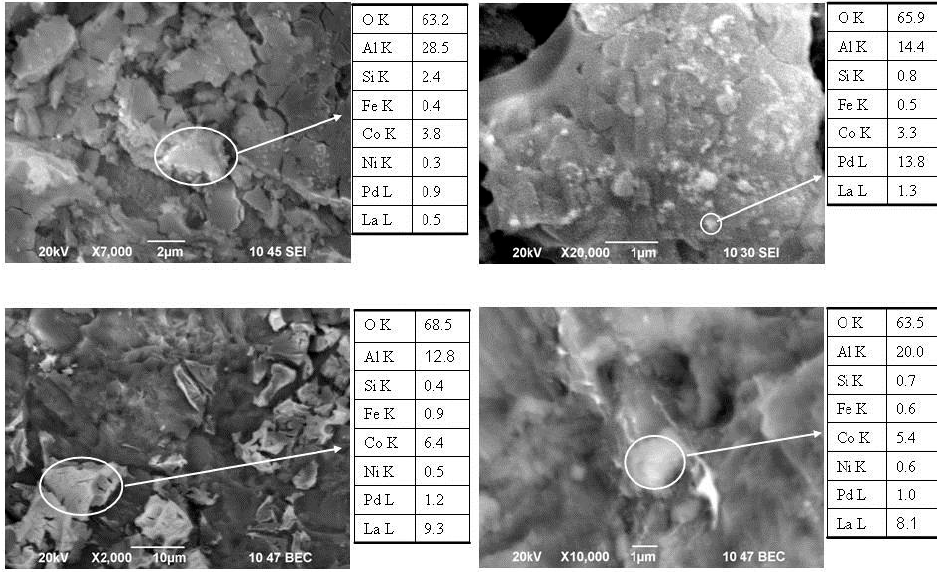
Figure 1. SEM images at different magnifications for Pd-LMO/Imp ( top ) and Pd-LMO/U-AACVD ( bottom ). The EDS results are also indicated.